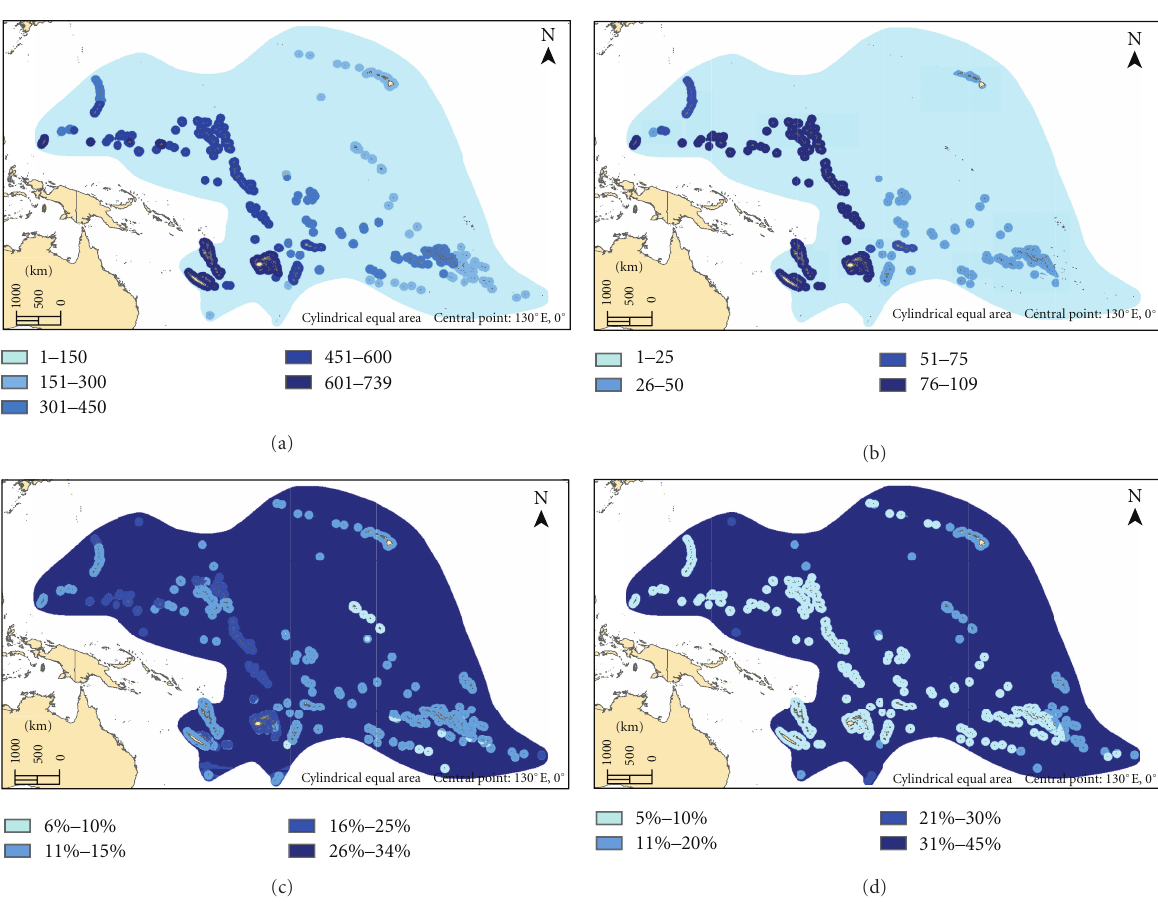
Figure 2: (a) Range and number of marine species assessed in this study (species richness), (b) species richness of all marine species assessed in threatened categories: Critically Endangered, Endangered, or Vulnerable, (c) proportion of species assessed in threatened categories, and (d) proportion of all species assessed as Data Deficient. (Sea birds were excluded from all analyses as maps were not available for all